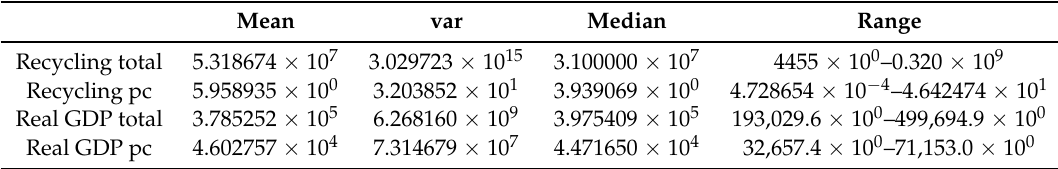
Table A1. Descriptive Statistics of the data for Rich States.